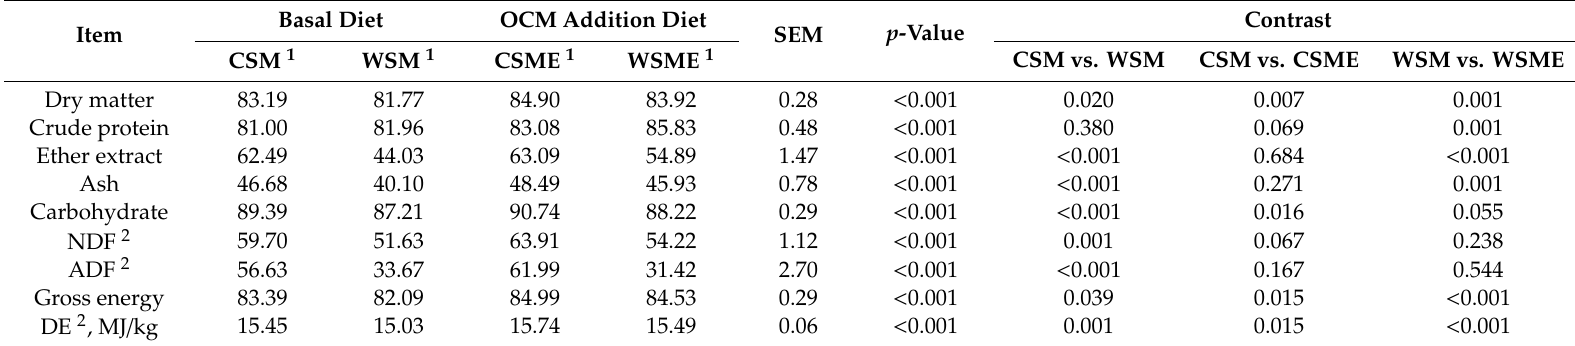
Table 5. E ff ects of the optimal carbohydrase mixtures on apparent total tract digestibility of nutrients and energy in growing pigs fed two types of diets, %.